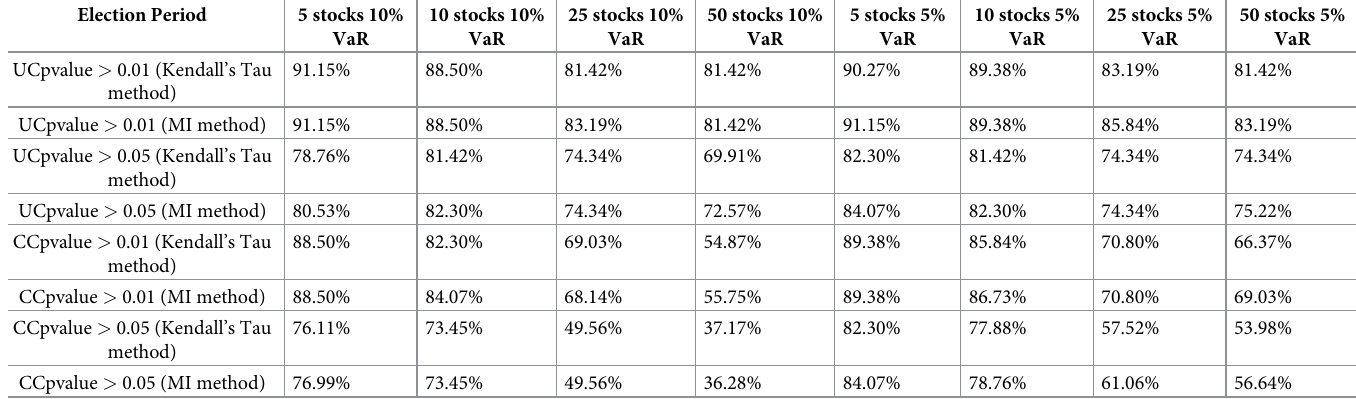
Table 3. Unconditional (UC) and conditional (CC) coverage tests at 1% and 5% level of significance: Post-election